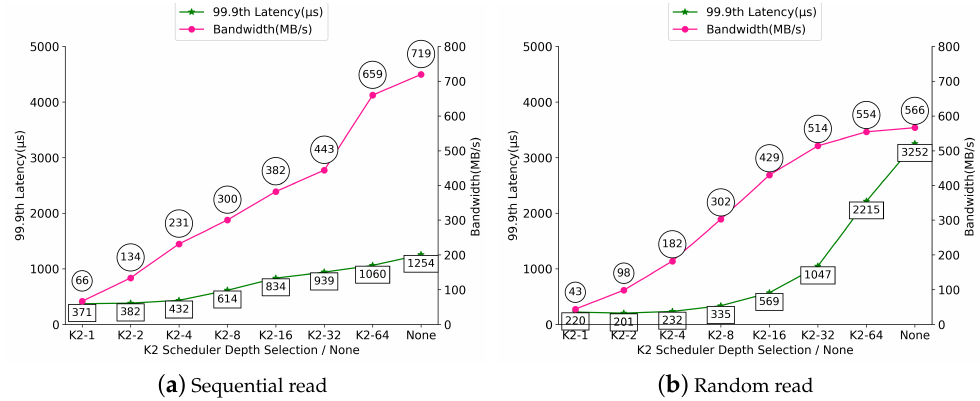
Figure 7. Performance of sequential/random read operations on a fully occupied SSD.